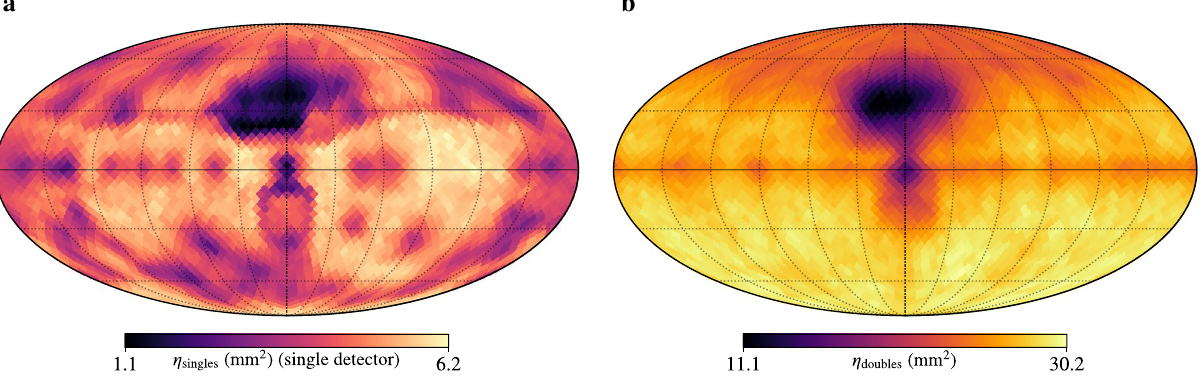
Figure 5. Simulated detector response examples. ( a ) 4 π singles effective area of a single detector near the center of the array (662 keV). ( b ) 4 π doubles effective area of the entire detector array (662 keV). Both images use the Mollweide projection with the origin at the center of the detector array and the positive X and Z axes pointing through the camera/lidar package and electronics box, respectively. Graticules are shown every 30 deg in polar and